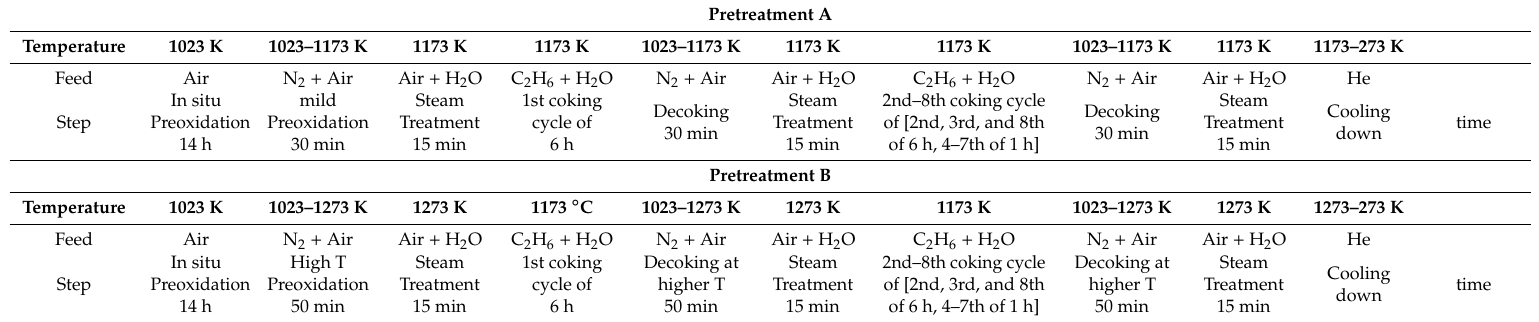
Table 2. Experimental sequence during the two performed